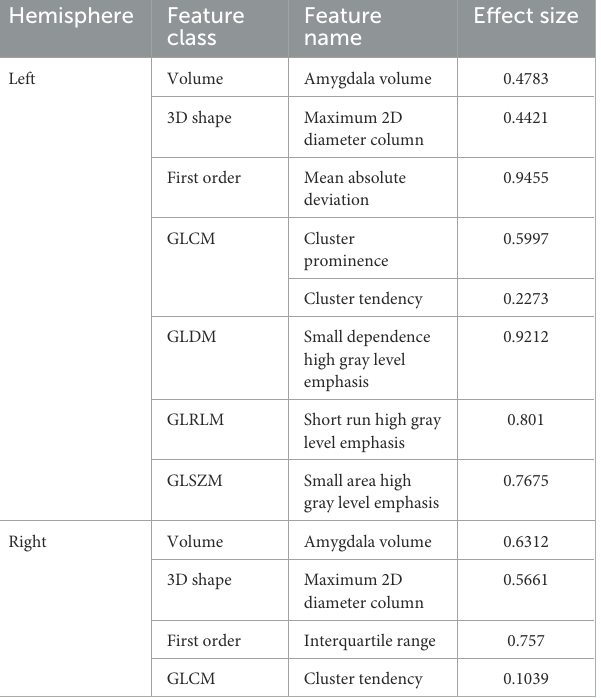
TABLE 4 Effect sizes of selected radiomics features and bilateral amygdala volume in GAD vs. HC task.